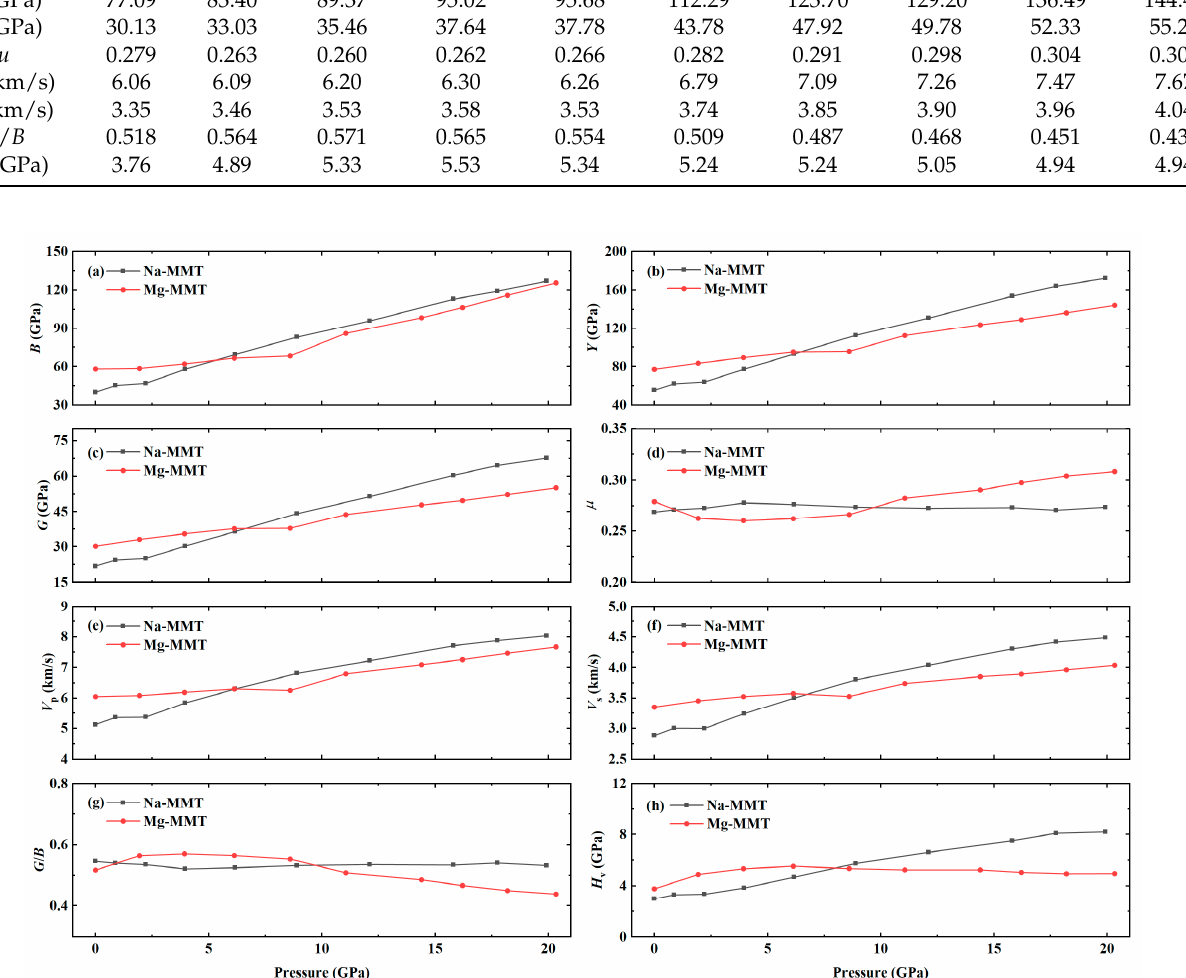
Figure 9. The calculated value of elastic modulus, Poisson’s ratio, wave velocity, Vicker’s hardness and Push’s modulus of Na-MMT and Mg-MMT under different pressure. ( a ) Bulk modulus ( B ); ( b ) Young’s modulus ( Y ); ( c ) shear modulus ( G ); ( d ) Poisson’s ratio ( µ ); ( e ) compression wave velocity ( V p ); ( f ) shear wave velocity ( V s ); ( g ) Push’s modulus ( G / B ); ( h ) Vicker’s hardness ( H v ). Table 13. The calculated bulk modulus ( B ), shear modulus ( G ), Young’s modulus ( Y ), Poisson’s ratio ( μ ), Pugh’s modulus ( G / B ), Vicker’s hardne ss ( H v ), compression wave velocity ( V p ), and shear wave velocity ( V s ) of the Na-MMT at given pres- sure.